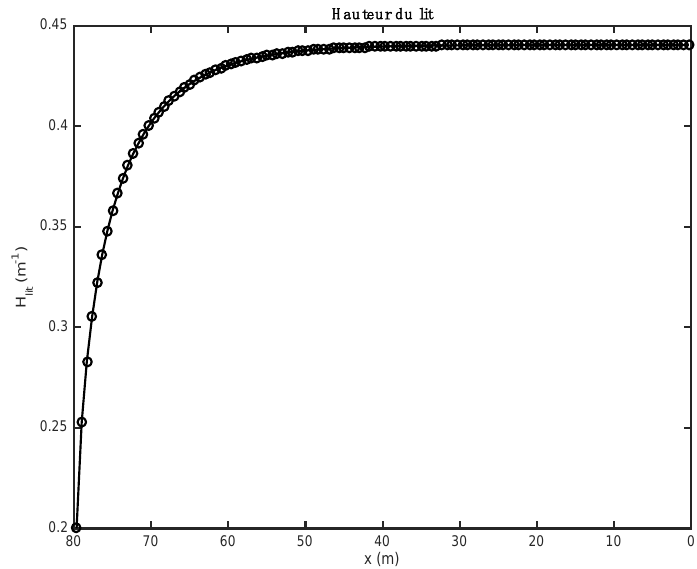
Figure 1. Evolution of the height of the bed along the axis of the kiln .